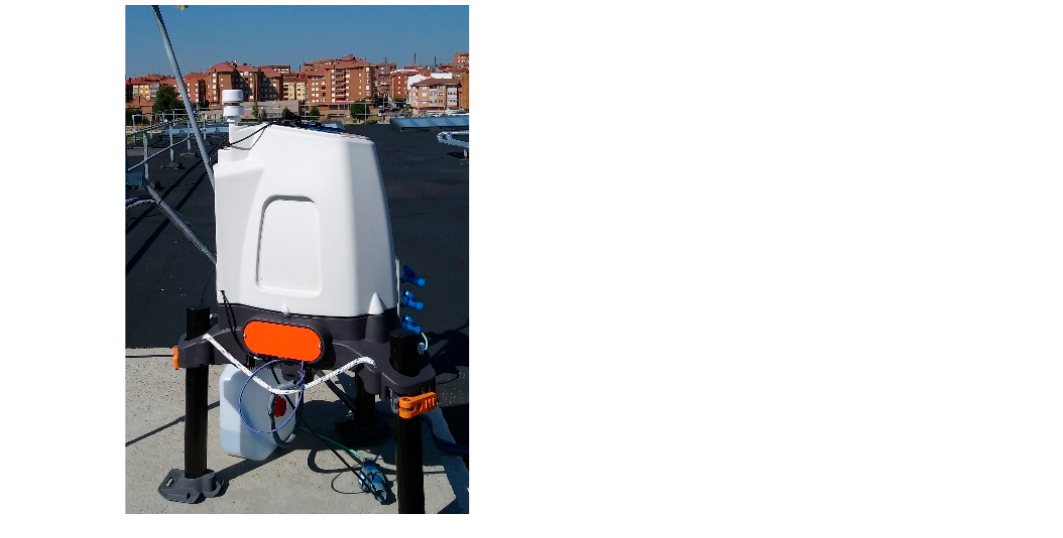
Figure 8. LIDAR located on the rooftop of a building at the University of León campus.